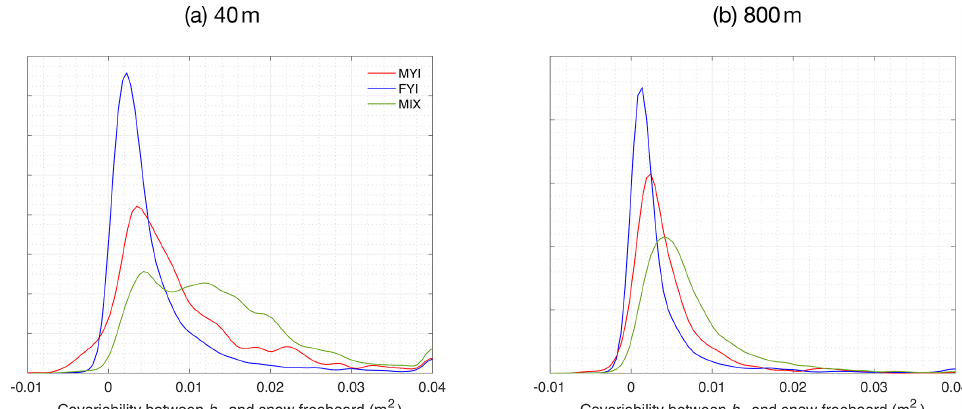
Figure 6. Covariability between F s and h s on 40m (a) and 800m (b) scale.